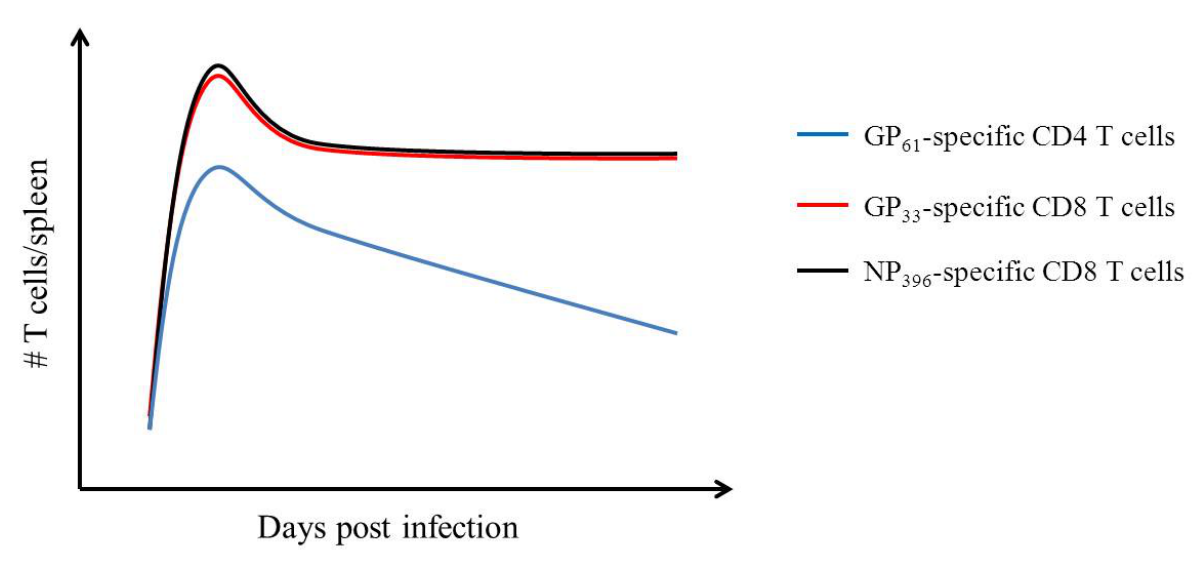
Figure 3. Schematic of epitope-specific CD4 and CD8 T cell response from acute activation to memory. Data adapted from Homann et al. 2001 [44]. Splenocytes were collected on the day post infection indicated. MHC tetramer staining was performed to enumerate T cells specific to the LCMV GP61 epitope- (CD4 T cell specific; blue line) as well as the LCMV CD8 T cell specific epitopes, GP33 (red line) and NP396 (black